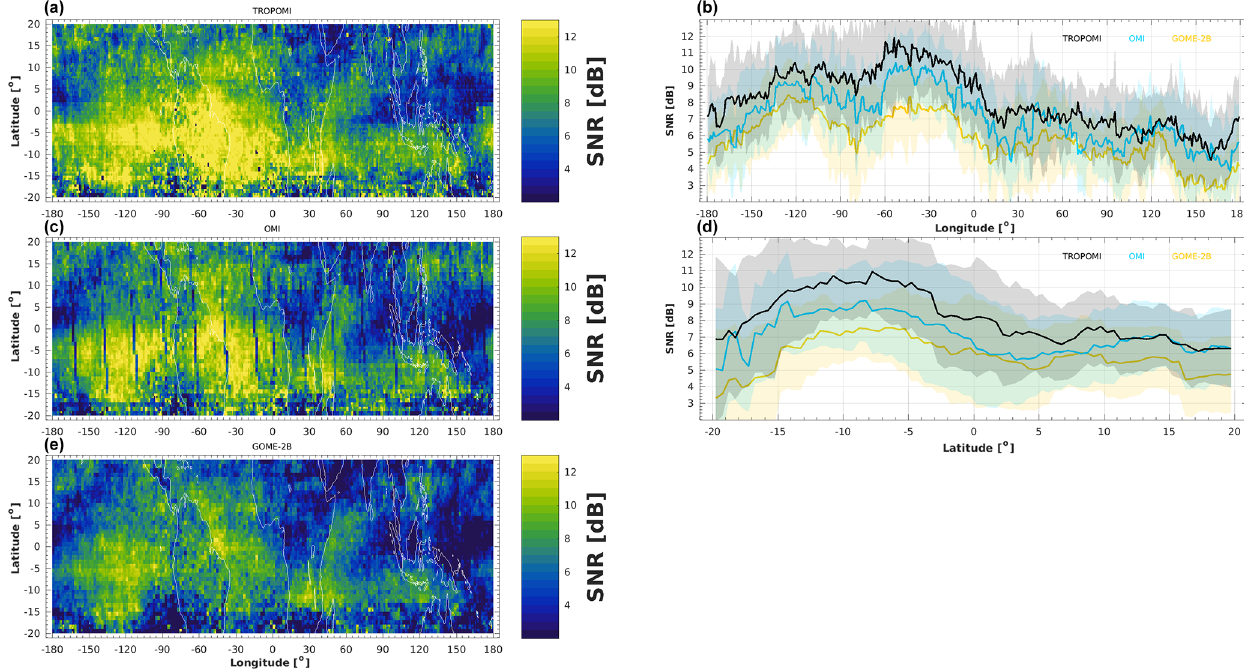
Figure 9. Maps (a, c, e) and latitudinal sections (b, d) of the signal-to-noise ratio for TROPOMI, OMI and GOME-2B. Shaded areas indicate 1 standard deviation over the zonal